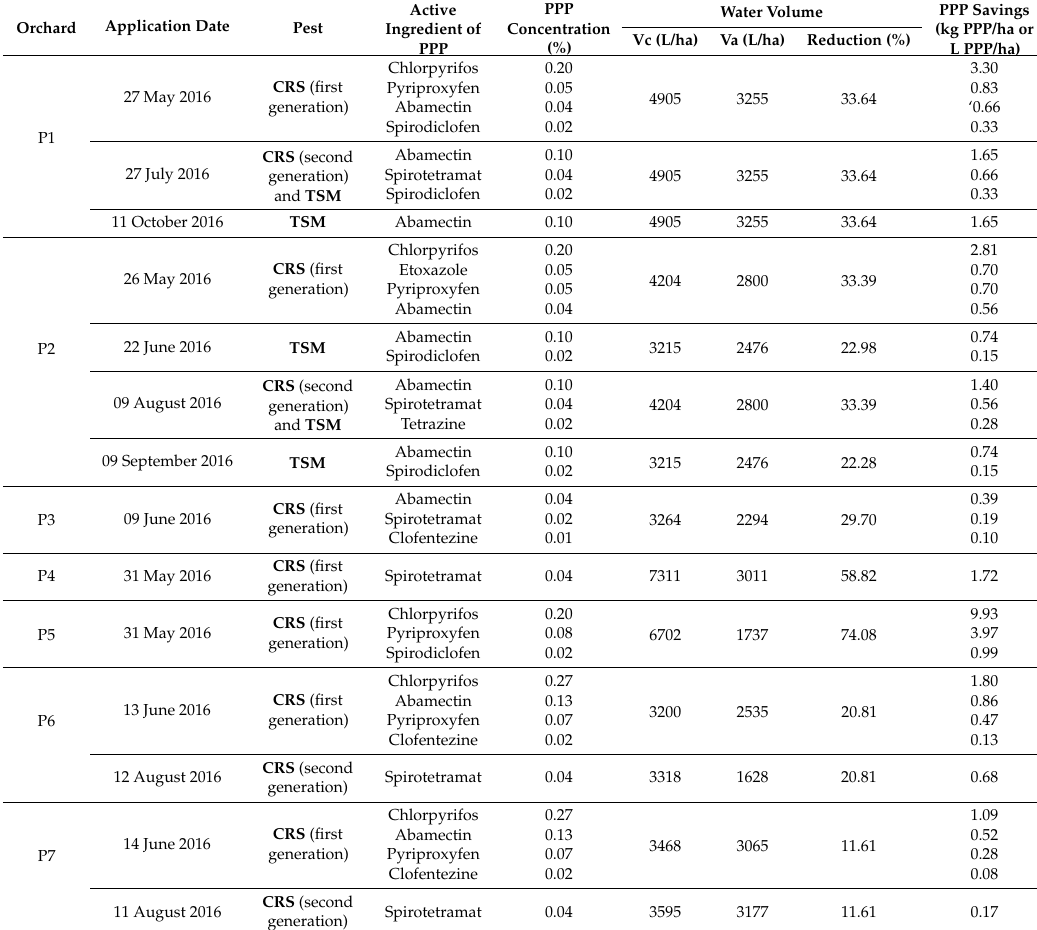
Table 5. Water volume used in the applications and the percentage of mix volume reduction and the PPP savings due to the use of the CitrusVol tool.